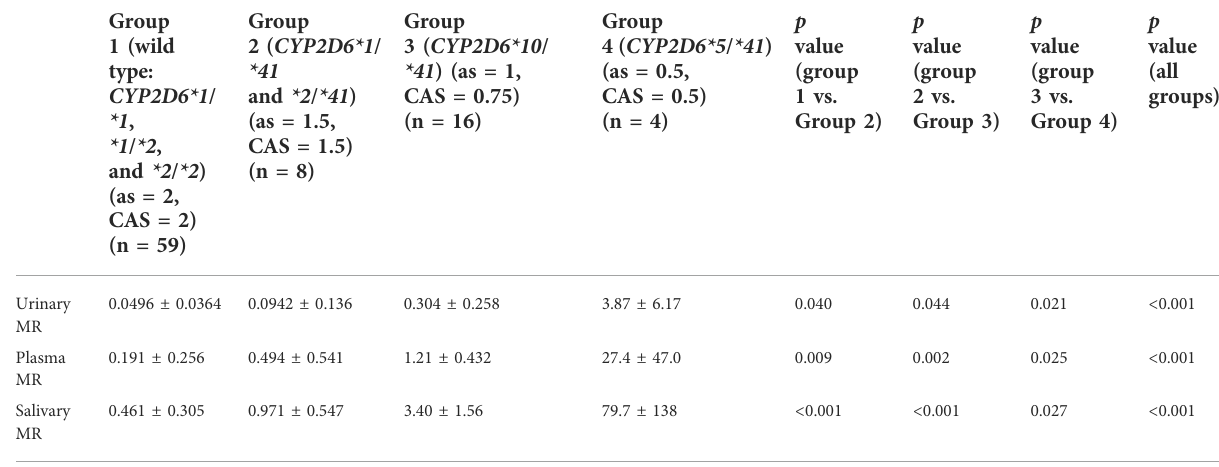
TABLE 2 The MRs for different Activity Score (AS) or Consensus Activity Score (CAS) groups based on the three phenotyping